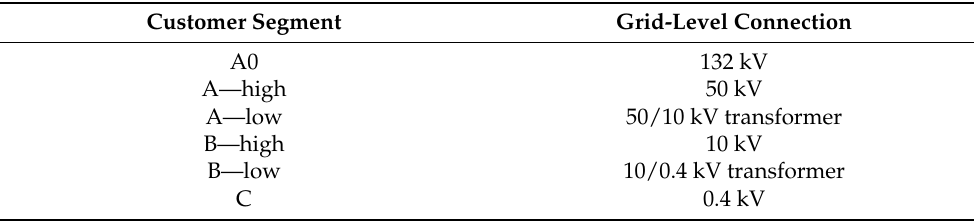
Table 11. Customer segmentation based on the grid-level connection [49].